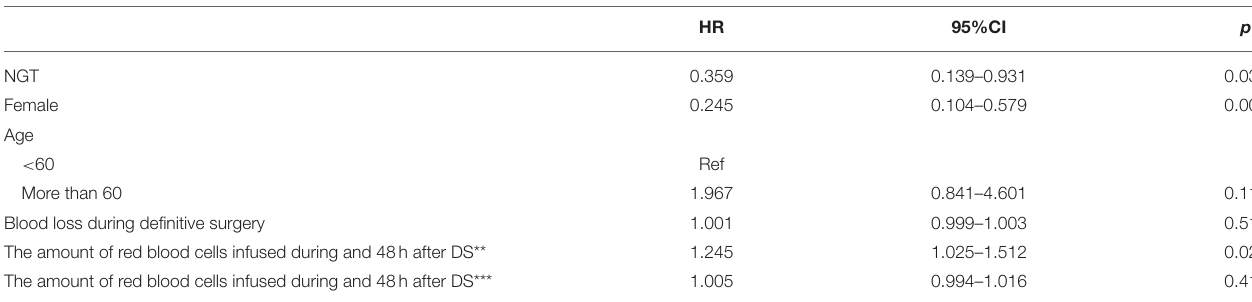
TABLE 3 | Adjusted regression for post-operative